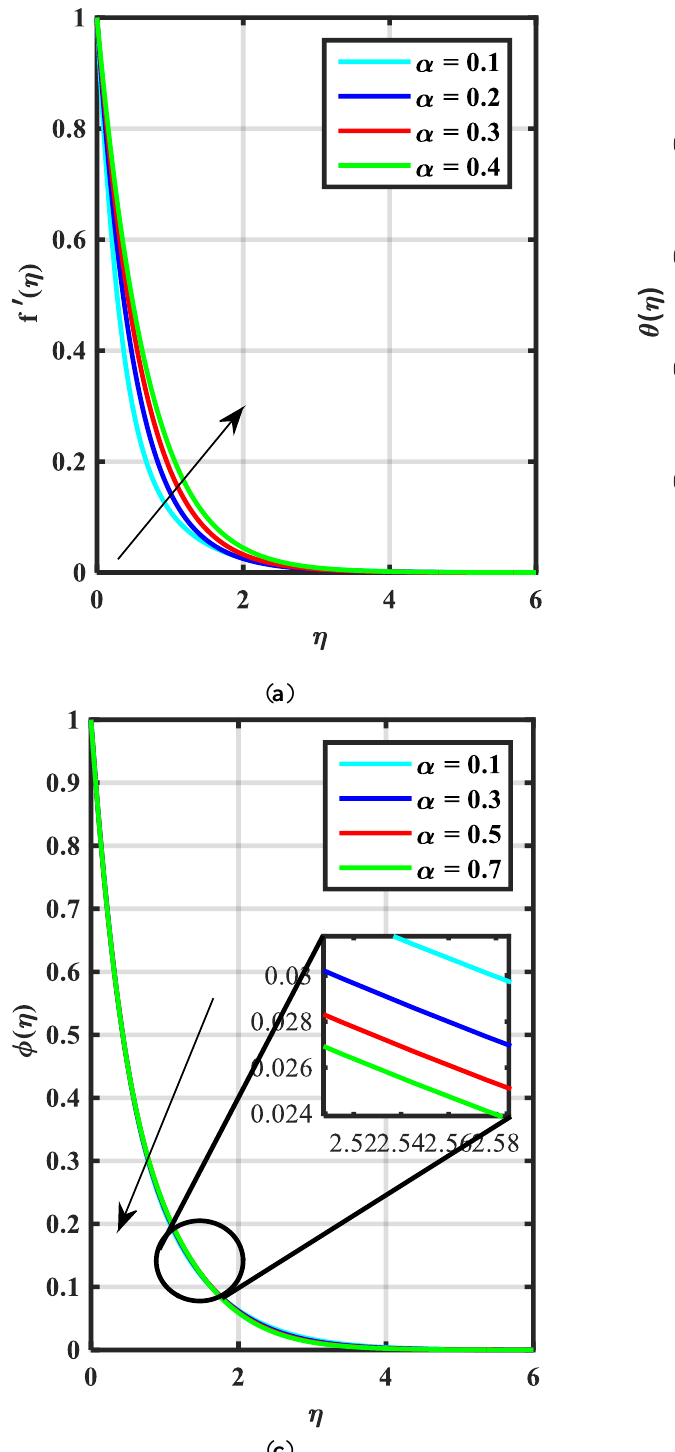
Figure 2. ( a – c ) Influence of 𝑓 ′ (𝜂), 𝜃(𝜂) 𝜙(𝜂) over Prandtl fluid parameter 𝛼 .